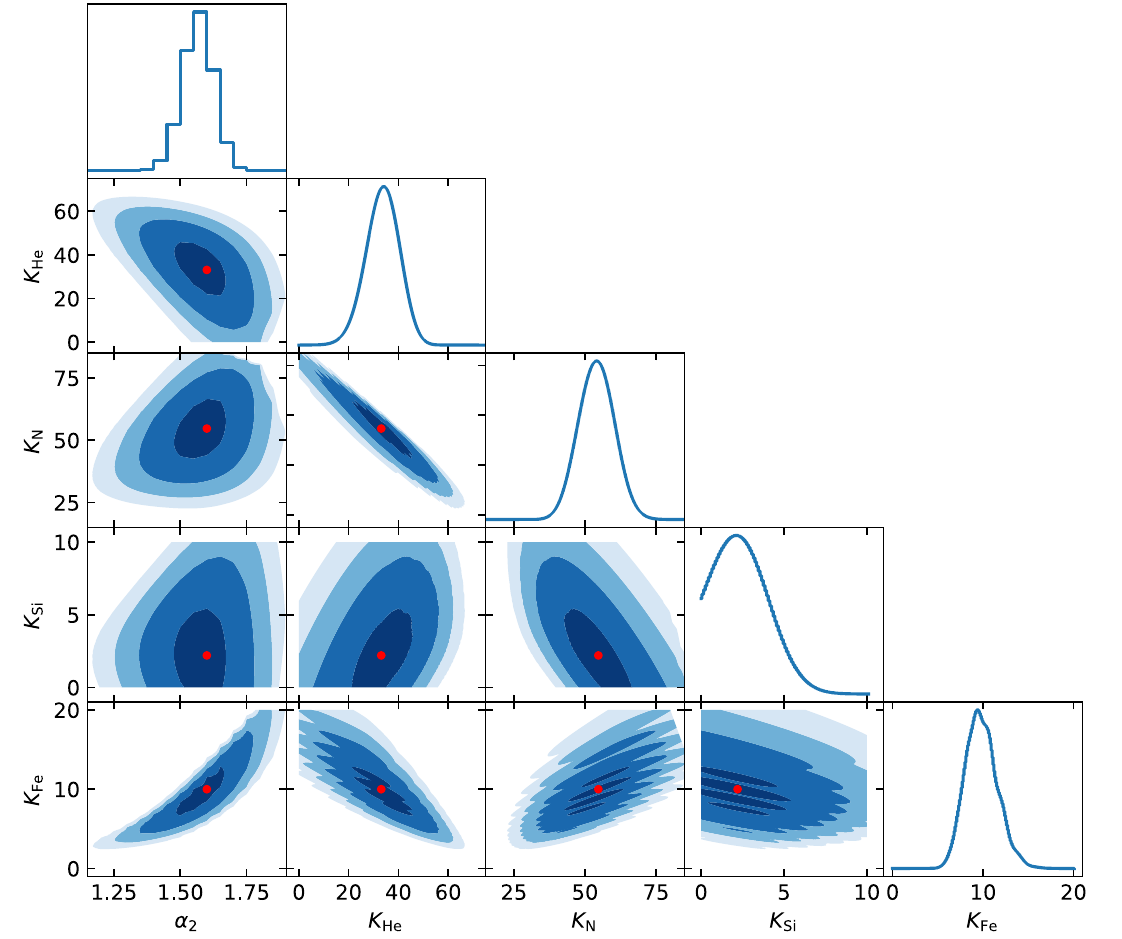
Fig. 7 Correlation between fit parameters for the best-fit case corre- sponding to m 1 = 3, m 2 = − 6, α 1 = 2 . 2, and f H = 1 . 5%, i.e., for the best-fit case SRE-1 listedin Table 4. It can be seen that a high fraction of Feisrequiredatinjectionalongwithahardinjectionspectralindex.The